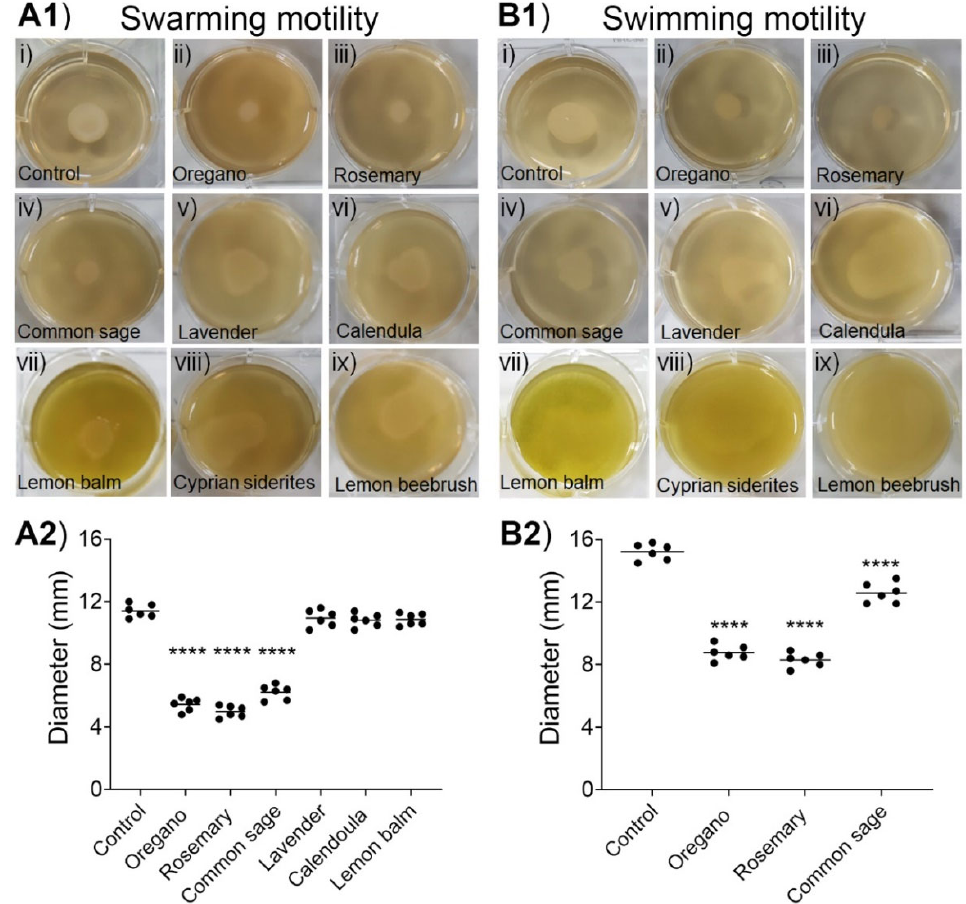
Figure 4. Inhibition of the swarming ( A1 ) and ( A2 ) and swimming ( B1 ) and ( B2 ) motilities of E. coli MG1655 by the ethanolic extracts . In panels (ii, iii) and panels (iv–ix), E. coli MG1655 was grown on LB agar containing 1 or 2 mg/mL, respectively, of the indicated ethanolic extract. In ( A2 ) and ( B2 ), horizontal bars indicate the mean values of six independent experiments. ANOVA followed by Tukey’s multiple ‐ comparison test was used for statistical analysis. Only statistically significant differences are shown, and they are indicated with asterisks: **** p < 0.0001 .